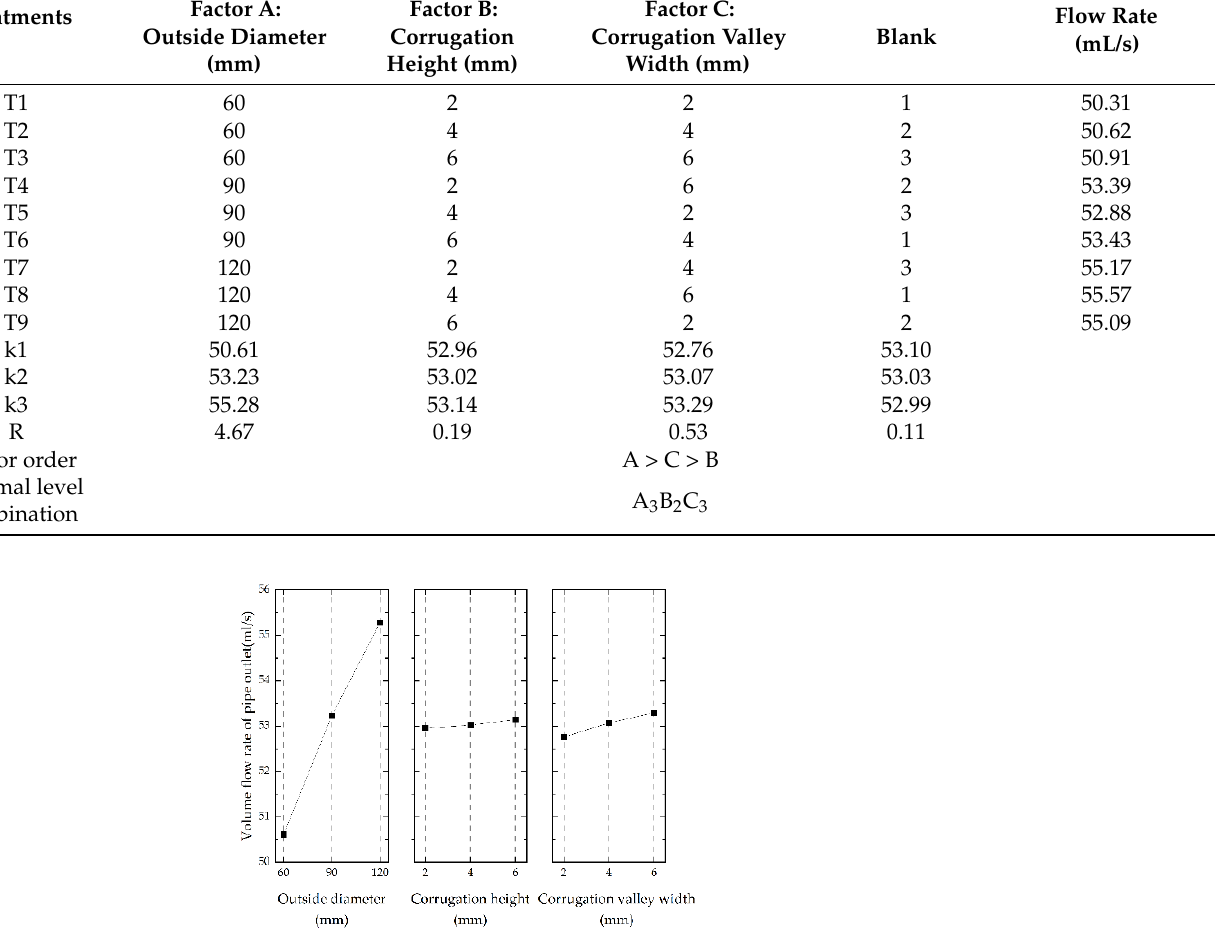
Figure 13. Relationships between the volume flow rate of the pipe outlet and factors.